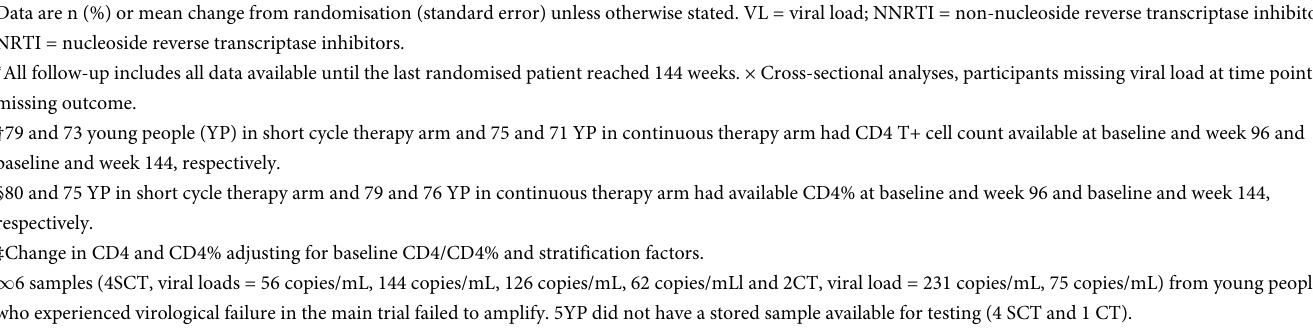
SCT arm (n = 16) compared to the CT arm (n = 4) (p = 0.005); there were 20 events in SCT versus 8 events in CT (incidence rate ratio 2.49, 95% CI: 0.71–8.66; p = 0.15) (Table 4). A large proportion 21 (75%) of SAEs were hospitalisations (15 SCT, 6 CT); other SAEs included other serious medical conditions (3 SCT, 1 CT), 1 death (SCT), 1 life-threatening event (CT) and 1 foetal malformation (SCT). Of all SAEs, 11 were for infections (8 SCT, 3 CT), 5 for neuropsychiatric disorders (headache, syncope, hemiparesis, intentional self-injury, sui- cidal ideation) (2 SCT, 3CT), 1 neoplasm (SCT) and 11 other (9 SCT, 2CT) (Table 5). Seven SAEs in 5 participants in the SCT arm occurred more than 24 weeks after the participant had resumed CT (Table 5). The only SAE considered by the Endpoint Review Committee, blind to randomised allocation, to be definitely HIV related was a relapse of Kaposi’s sarcoma in a young person following the SCT strategy. There were a further 13 events (8 in SCT arm, 5 in CT) which were considered to be of uncertain in relationship to HIV.